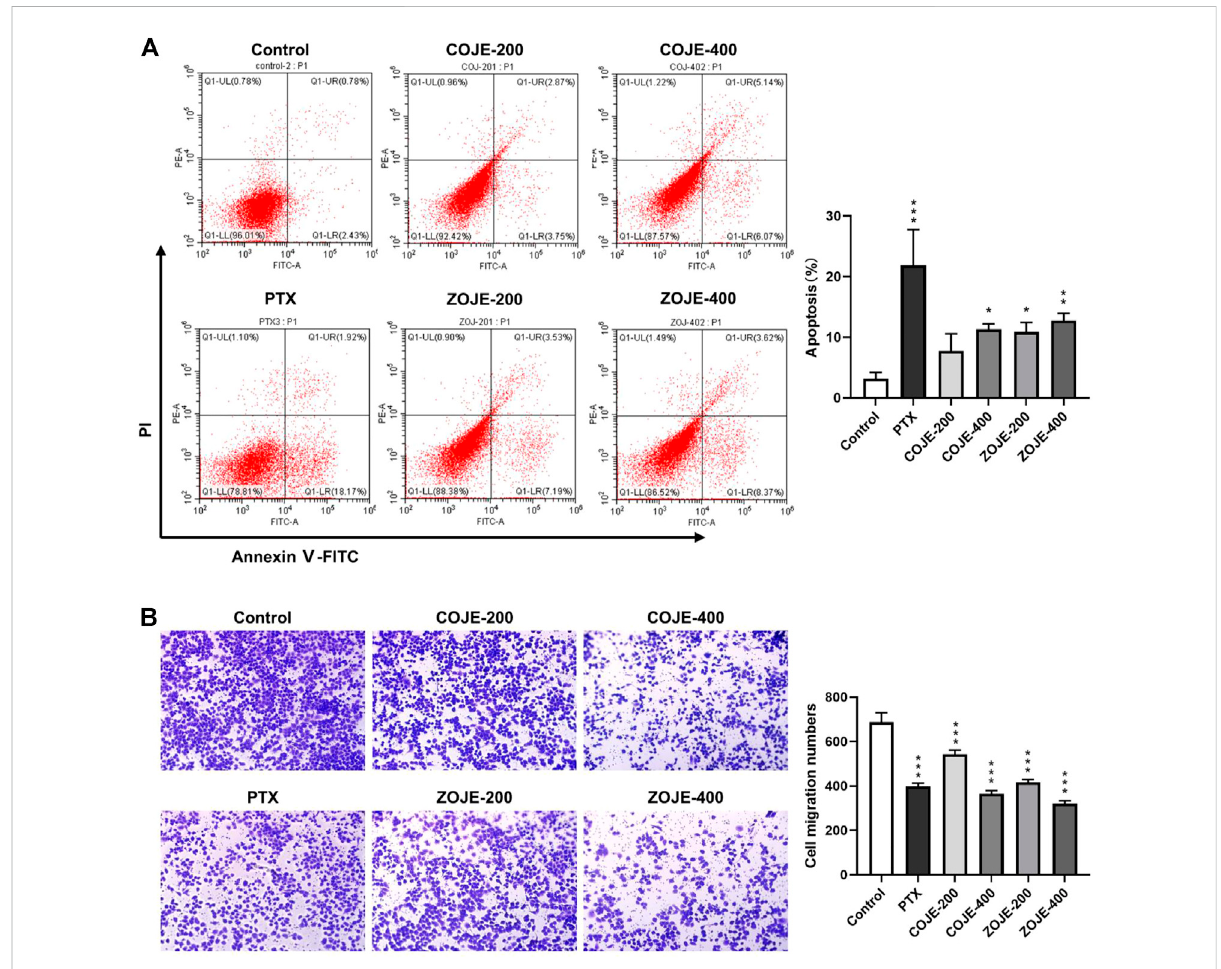
FIGURE 3 OJE induced apoptosis and inhibited migration of NCI-H1299 cells. ( A ) Induction of apoptosis in NCI-H1299 cells treated with vehicle, OJE (200, and 400 μ g/ml) or PTX (500 nmol/L). NCI-H1299 cells were exposed to vehicle, OJE or PTX at designated concentrations for 48 h. The cell apoptosis rate was treated statistically. ( B ) NCI-H1299 cells were seeded in the top chamber of transwell with serum-free medium and treated with vehicle,OJE(200,and400 μ g/ml)orPTX(500 nmol/L).Afterabout48 h,migratedcellswere fi xed,stained,photographedandquanti fi ed(10×). Migratedcellsinthree fi eldsselectedrandomlywerecountedandphotographedunderalightmicroscope.Dataareexpressedasmean±SDofthree independent replicates. (* p < 0.05, ** p < 0.01, *** p < 0.001 compared with